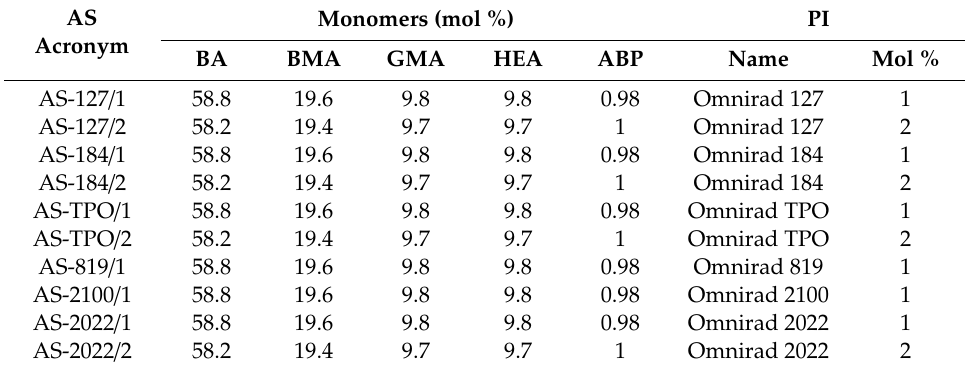
Table 2. Compositions of monomers and photoinitiators for preparation of acrylic syrups